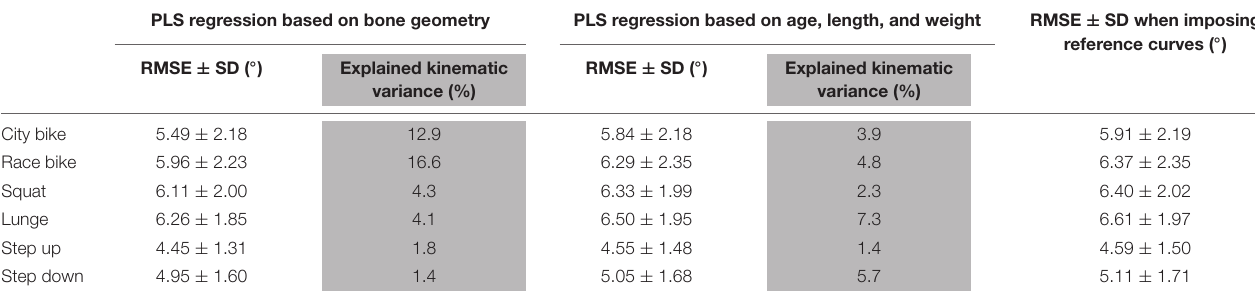
TABLE 4 | Partial least squares regression of the demographics and the combined femur and shank model PC weights to predict ADL kinematics. PLS regression based on bone geometry PLS regression based on age, length, and